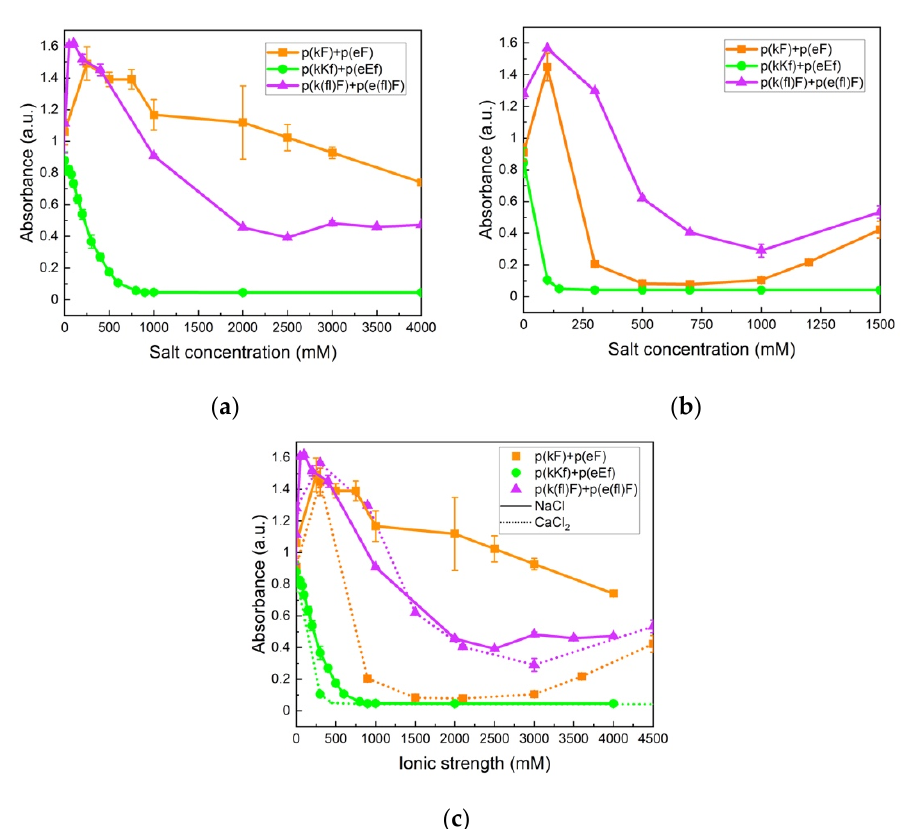
Figure 7. Turbidity measurements of sequence pairs: ( a ) at varied concentrations of sodium chloride (NaCl); ( b ) at varied concentrations of calcium chloride (CaCl 2 ); ( c ) at varied ionic strengths of NaCl (solid lines) and CaCl 2 (dotted lines). High stability is observed for p(kF) + p(eF) and p(k(fl)F) + p(e(fl)F) against both salts. p(kKf) + p(eEf), with higher charge density, is more sensitive to the screening effect of salt, showing a critical salt concentration at 900 and 150 mM for NaCl and CaCl 2 , respectively. All sequence pairs were prepared at equal stoichiometry with a total concentration of 5 mM with respect to the monomer charge.